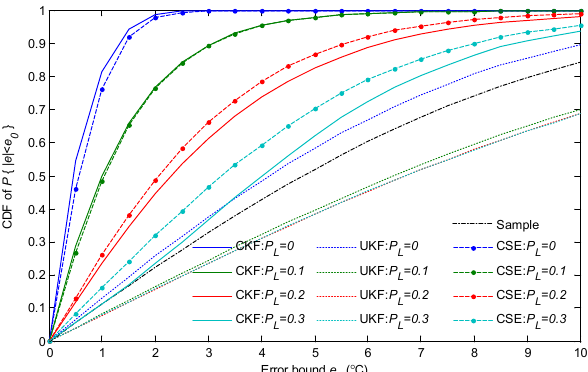
Figure 9. The cumulative distribution function (CDF) of the absolute error of surface temperature estimation with different packet loss probabilities.